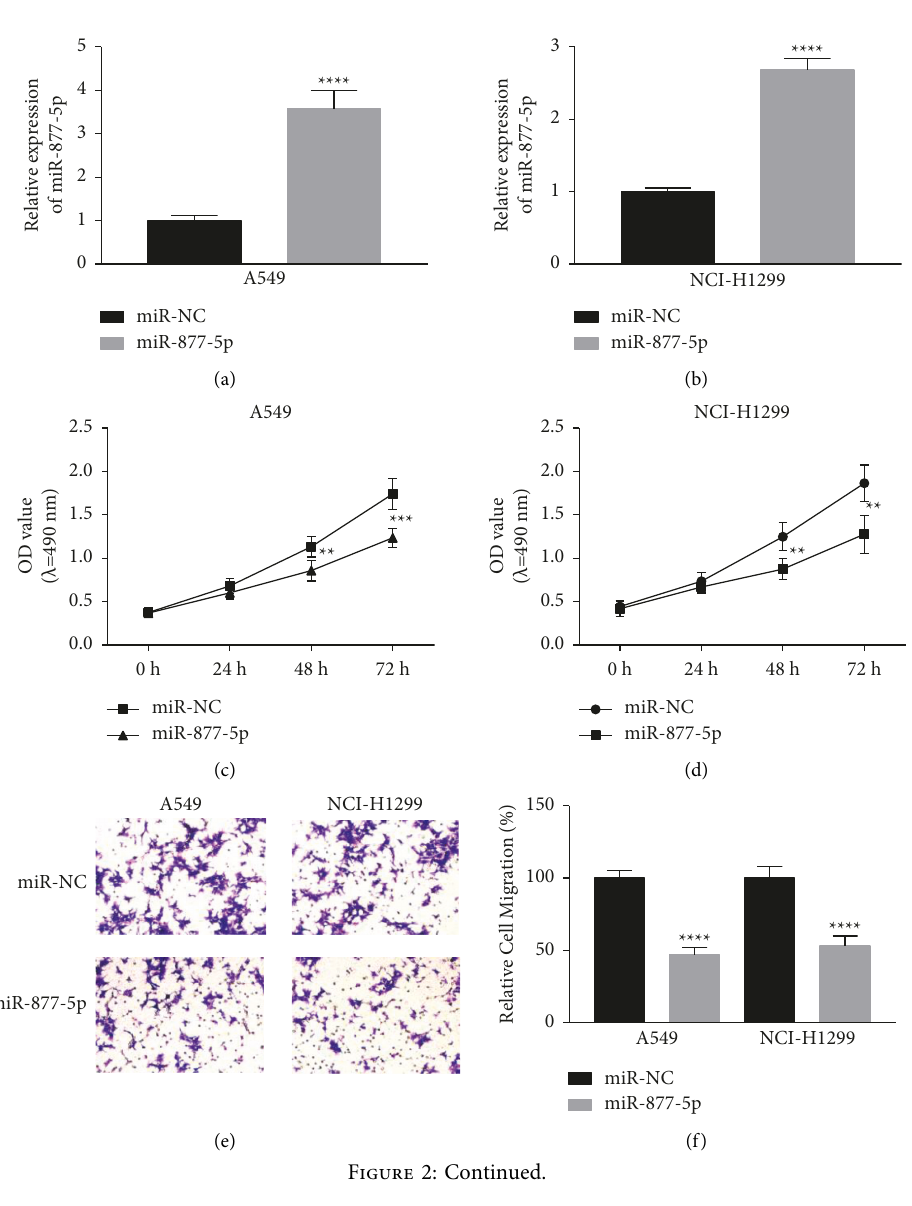
Figure 1: The expression of miR-877-5p in NSCLC tissues and cell lines. (a) RT-qPCR analyses of the expression levels of miR-877-5p in 37 pairs of NSCLC tissues and adjacent normal tissues. (b) Expression levels of miR-877-5p were detected by RT-qPCR in four NSCLC cell lines (NCI-H661, NCI-H460, A549, and NCI-H1299) and a nontumorigenic bronchial epithelium cell line (BEAS-2B). ∗ P < 0 . 05, ∗∗ P < 0 . 01, ∗∗∗ P < 0 . 001 and ∗∗∗∗ P < 0 . 0001 vs. normal